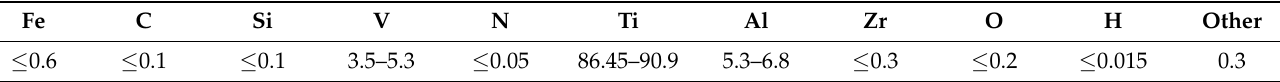
Table 2. Element composition of Ti-6Al-4V alloy